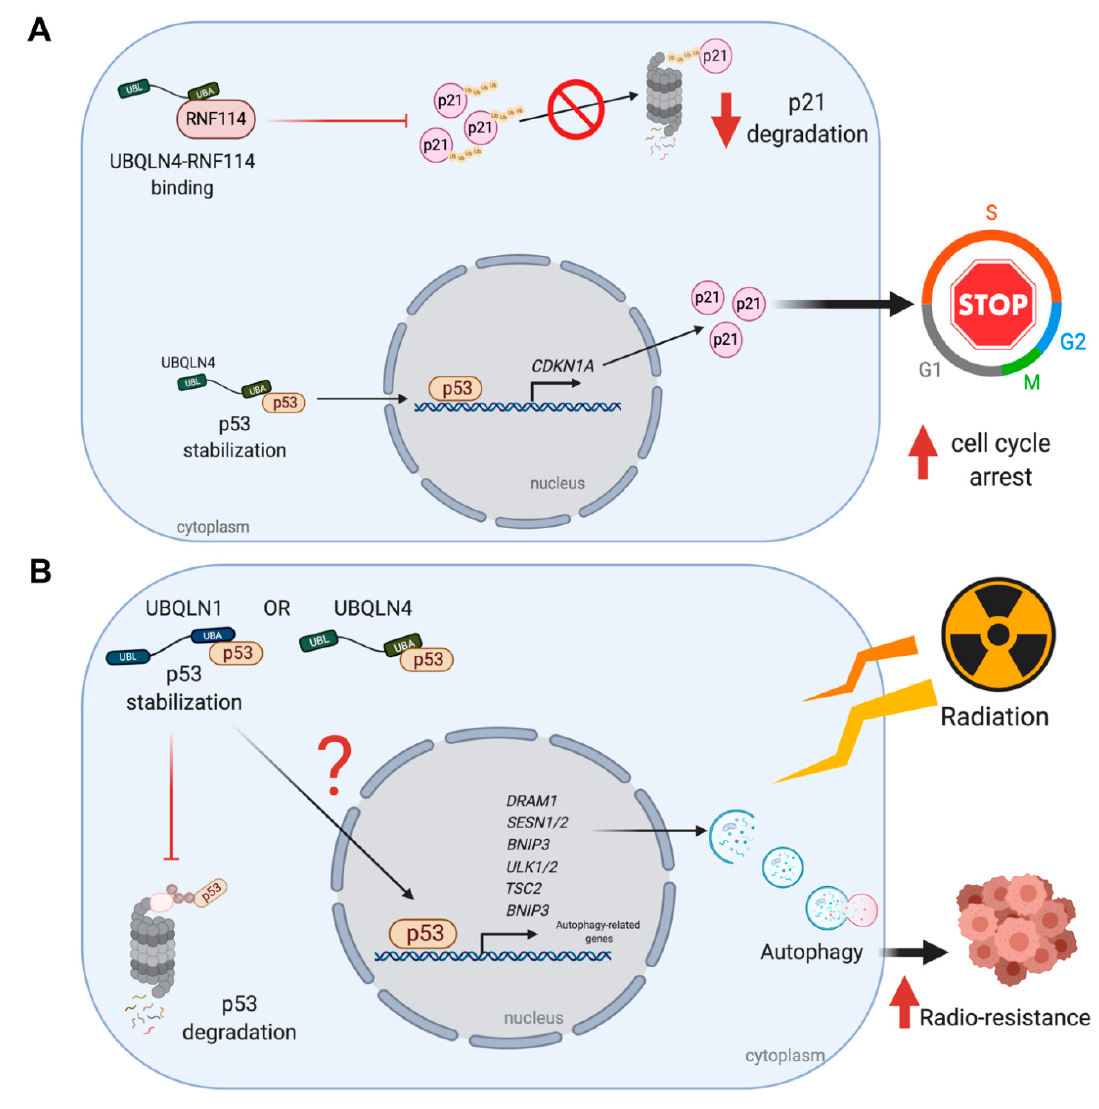
Figure 2. UBQLNs and p53 networking in cancers. UBQLNs stabilizes p53 and RNF114, two essential regulators of p21. ( A ) UBLQN4 physically interacts with p53, allowing the activation of p21 transcription and translation. Binding of UBQLN4 and RNF114 leads to the inhibition of p21 ubiquitination and degradation via UPS. ( B ) The stabilization of p53 by UBQLNs might induce transcription of autophagic related genes and further autophagosome formation. The autophagic induction can increase radio-resistance in cancer cells upon ionized radiation.